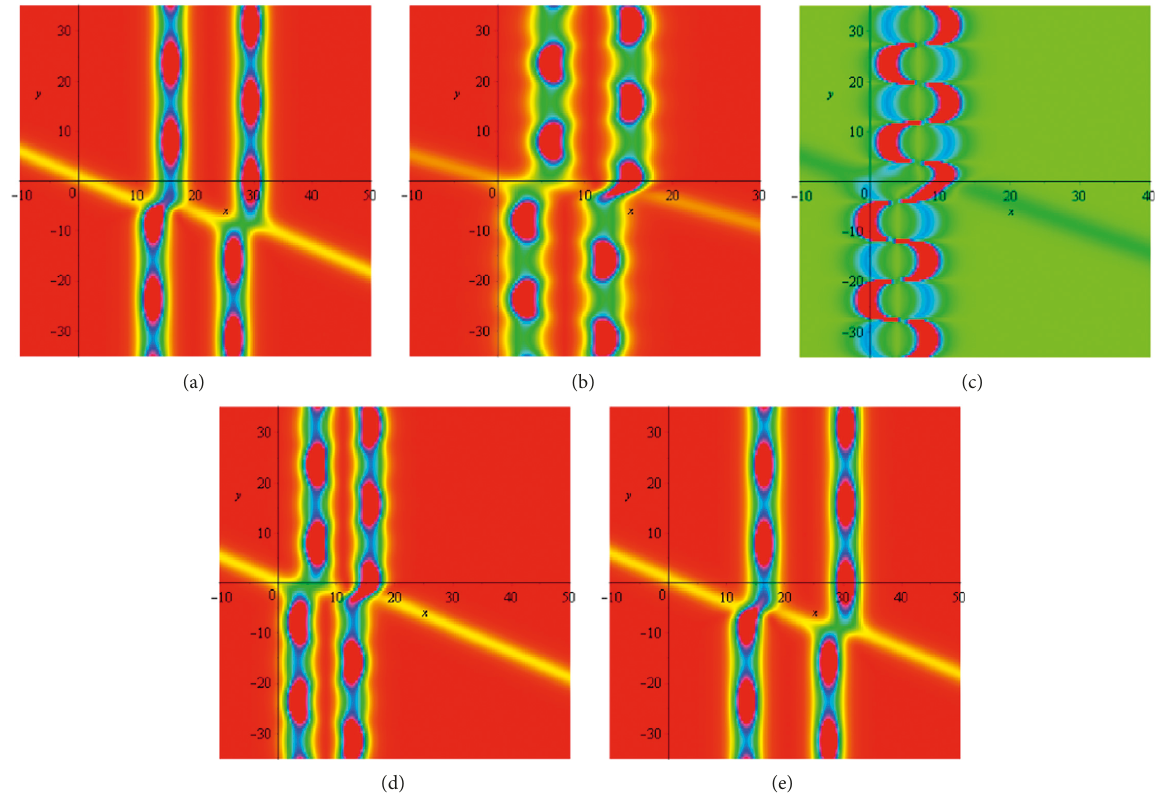
� 1 , σ � 1 , κ � 1/3 , σ � 1 , c � 1/5 , ϕ ( t ) � t + 1/100 , ϕ 1 1 1 2 2 1